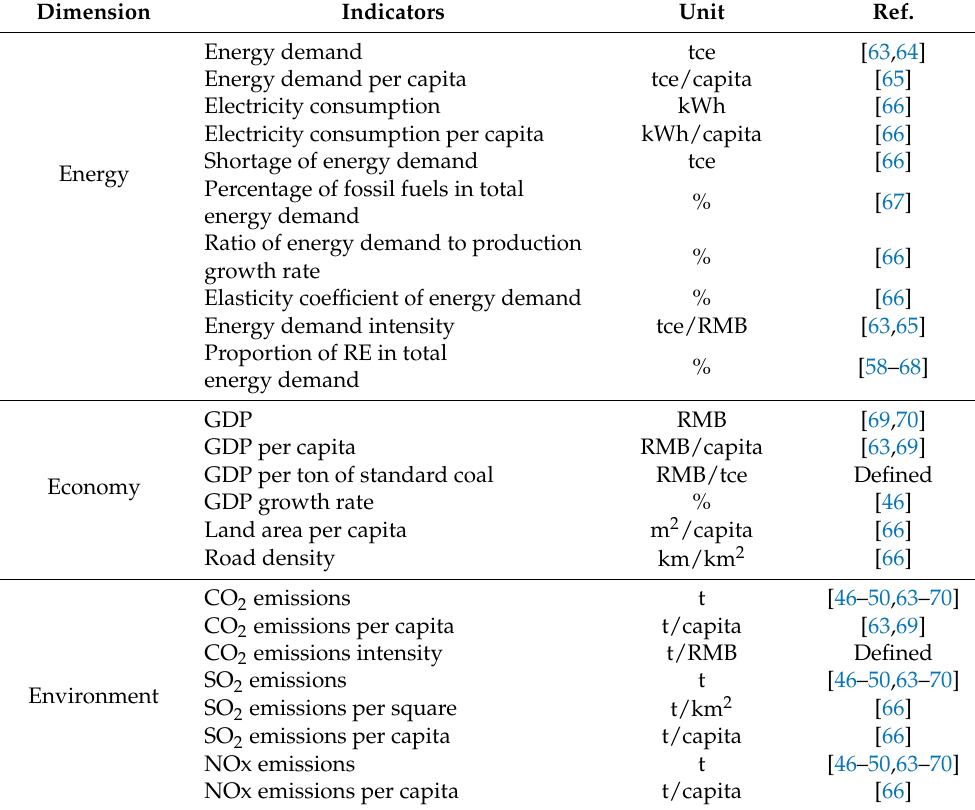
Table 2. The 3E–S evaluation system for municipal sustainable development. Dimension Indicators Unit